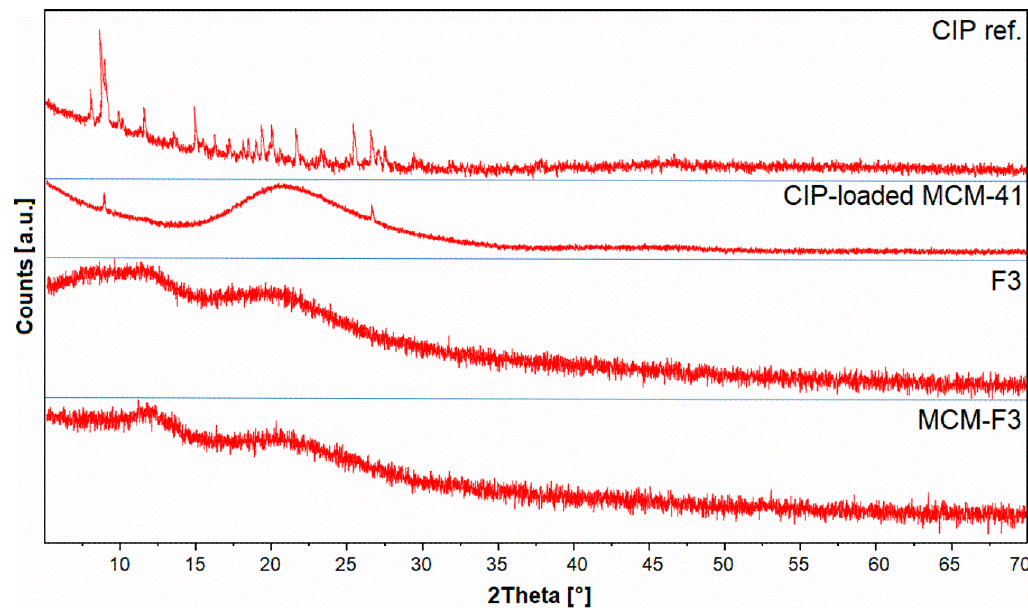
Figure 4. The XRD patterns of solid films of MCM ‐ F3 and F3, CIP ‐ loaded MCM ‐ 41, and CIP reference. The DSC thermograms of solid films of MCM ‐ F3, F3, unloaded MCM ‐ 41, freeze ‐ dried CIP (as